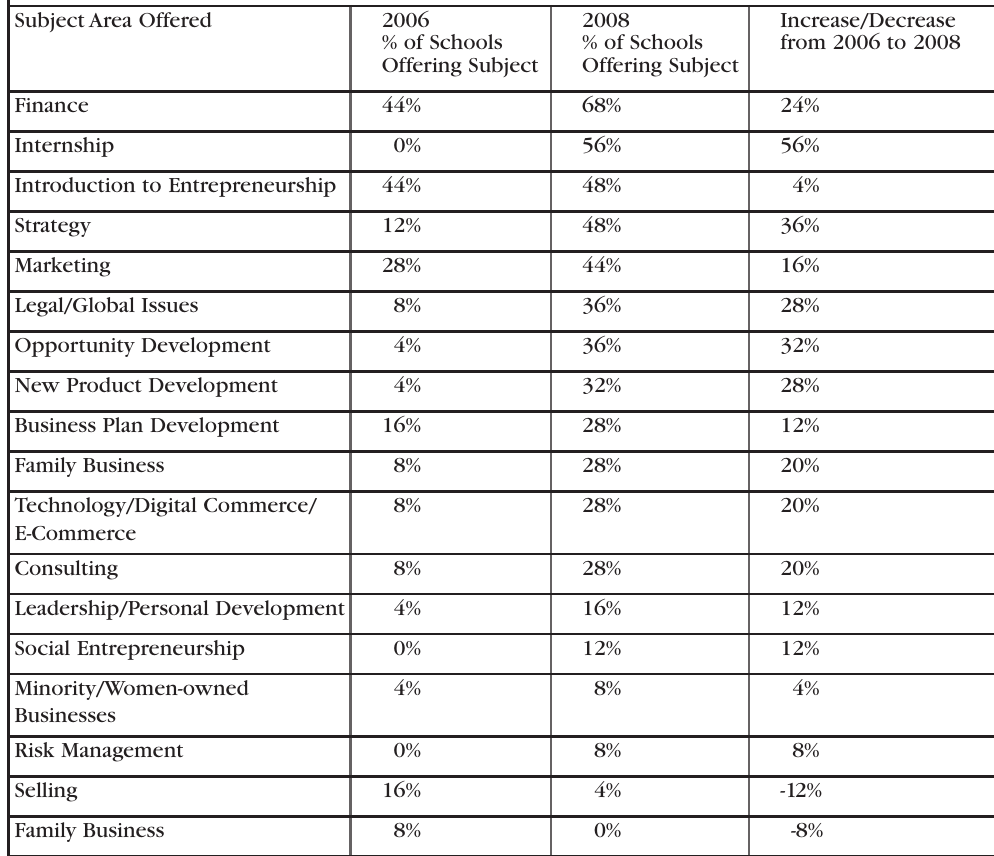
Table 1. Course Types by Percentage Compared from 2006 to